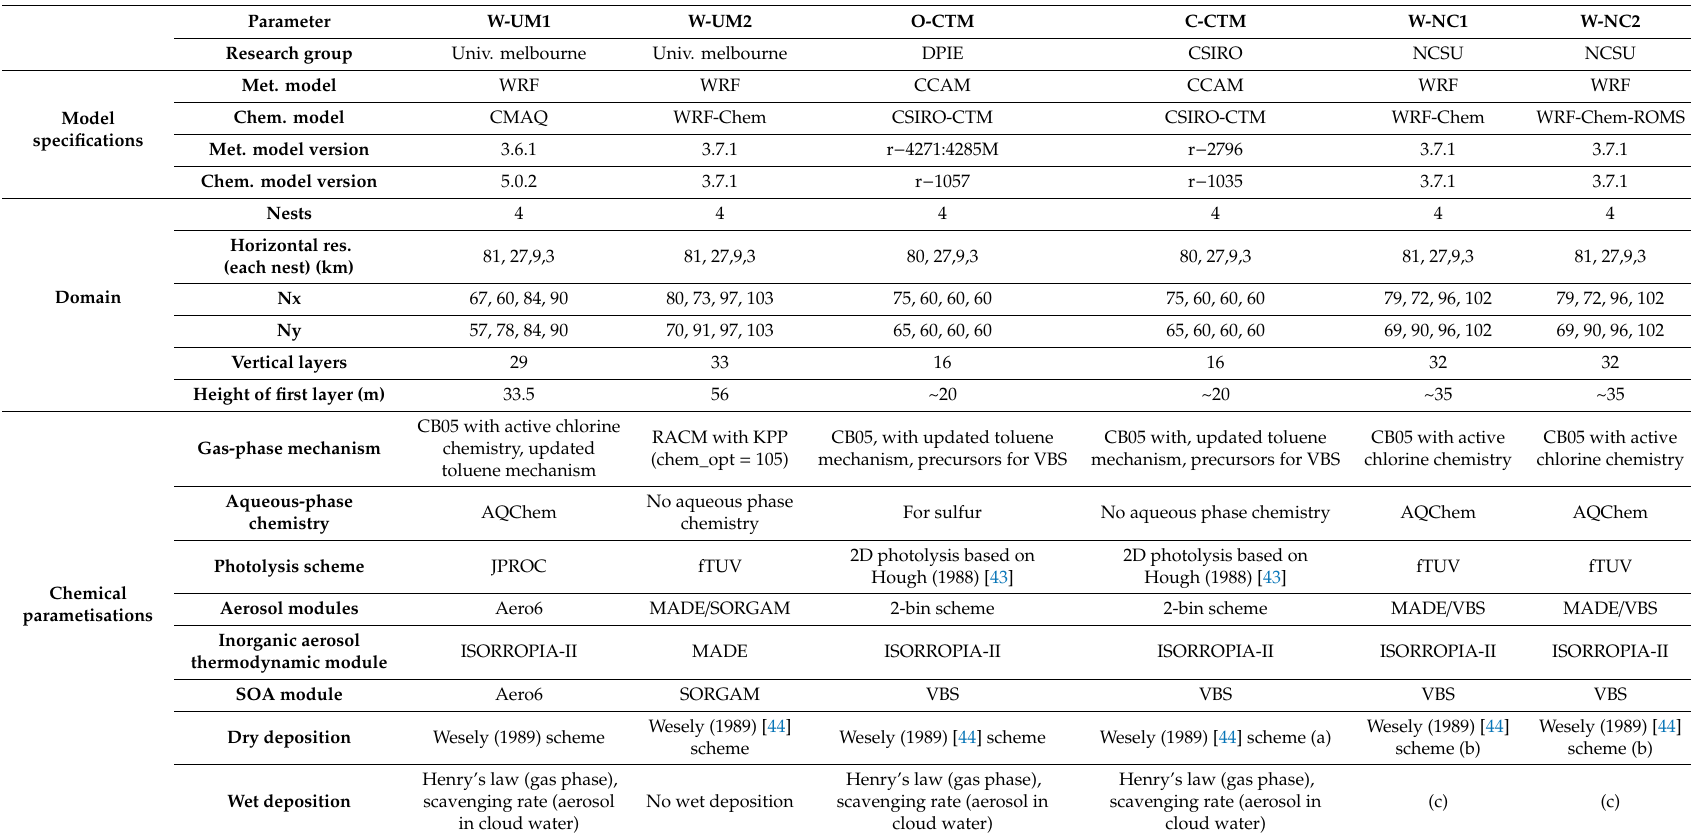
Table 1. Summary of the details of the six air quality modelling systems used in the